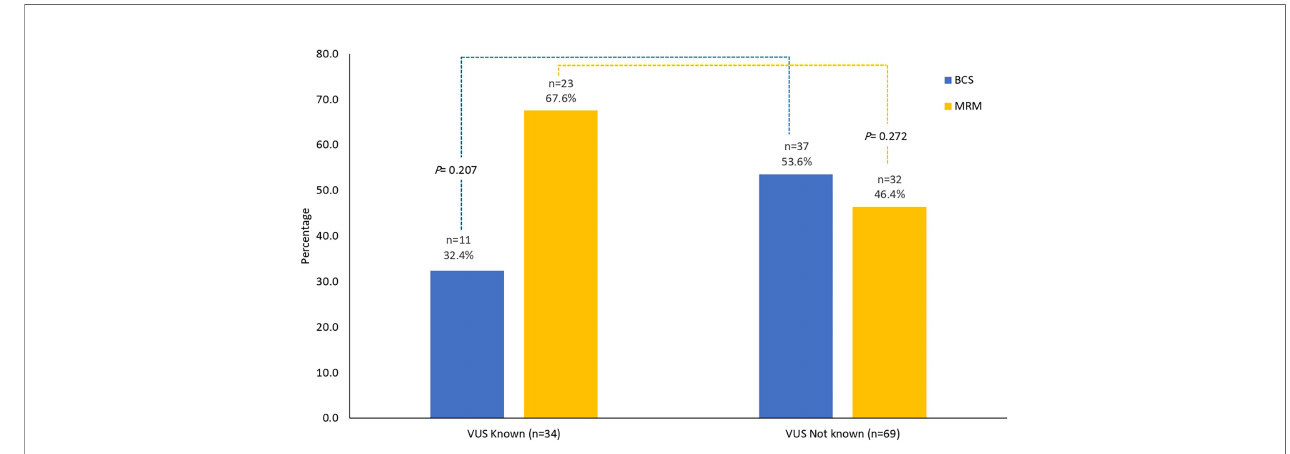
FIGURE 2 | Surgical interventions. Surgical interventions among patients with results of VUS known prior to surgery (n = 34) and those without (n = 69). No difference in the rates of MRM ( p = 0.272) or BCS ( p = 0.207). MRM, modi fi ed radical mastectomy; BCS, breast-conserving surgery; VUS, variants of uncertain signi fi